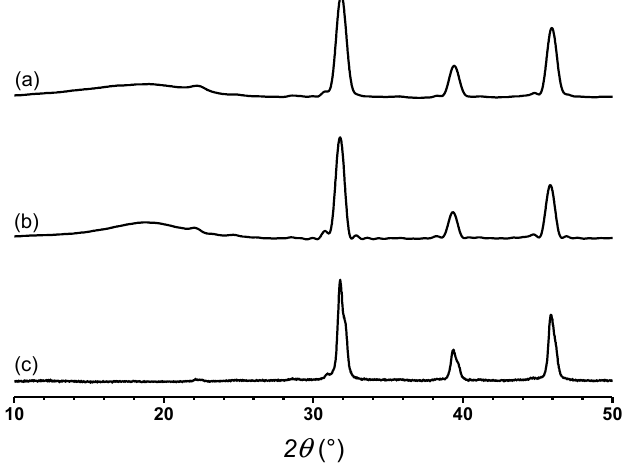
Figure 7. X-ray diffraction analysis of SEBS/BaTiO 3 20 ( a ) and SEBS/SEBS-g-IA 60/BaTiO 3 20 ( b ) and BaTiO 3 (c).